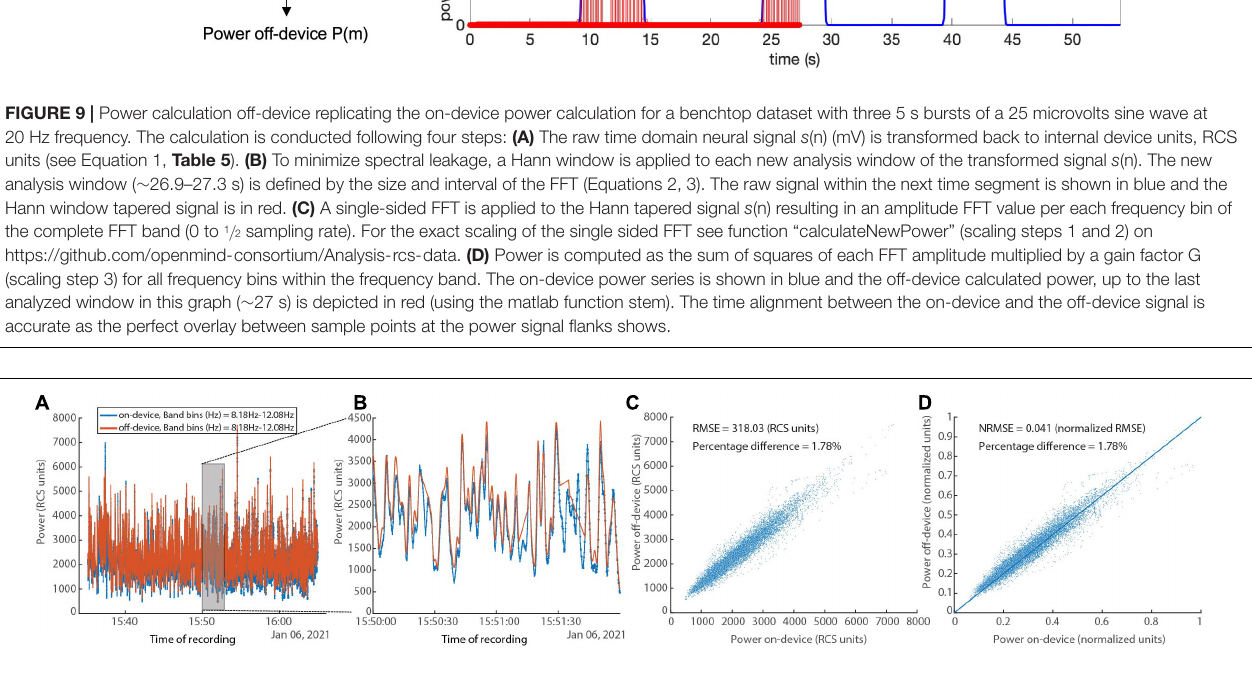
accurately understanding how neural activity, stimulation, and symptoms relate for the clinical management of implanted patients. Similarly, viewing these different datastreams together